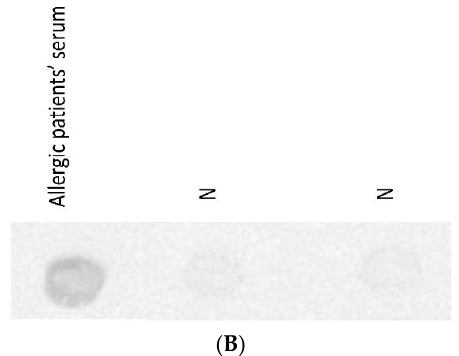
Figure 3. ( A ) IgE reactivity to nCSA in patients sensitised to hen’s egg white determined by dot blot. The grid above shows the patient ID described in Table 1 corresponding to each spot. nCSA-sensitised patients are highlighted in the grid. Dots denoted by N are sera from nonallergic (control) subjects. A to C represent row identity and I to VIII represent column identity in the grid and the corresponding Western dot blot. ( B ) IgE reactivity to rCSA of sera from patients sensitised to nCSA described in Figure 3 by Western dot-blot analysis. Dots denoted by N are sera from nonallergic healthy (control) subjects.